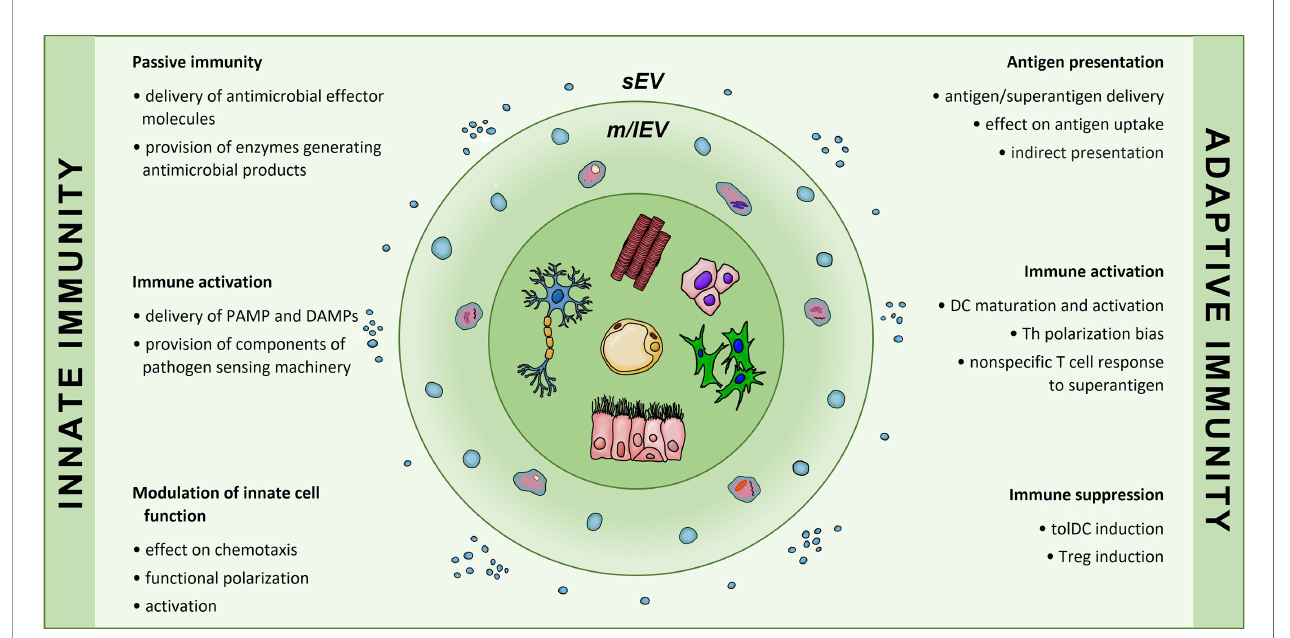
FIGURE 2 | Involvement of non-immune cell-secreted extracellular vesicles in immunological processes of innate and adaptive immunity. Extracellular vesicles produced by cells of non-immune origin participate in exchange of information that contributes to immune responses. In the innate arm EVs enable passive immunity and may both induce activation and modulate innate cell function. In the adaptive arm EVs may in fl uence antigen presentation, affect dendritic cell differentiation and phenotype; they have also been implicated in T cell polarization into Th or Treg subsets. sEVs, small EVs; m/lEVs, medium/large